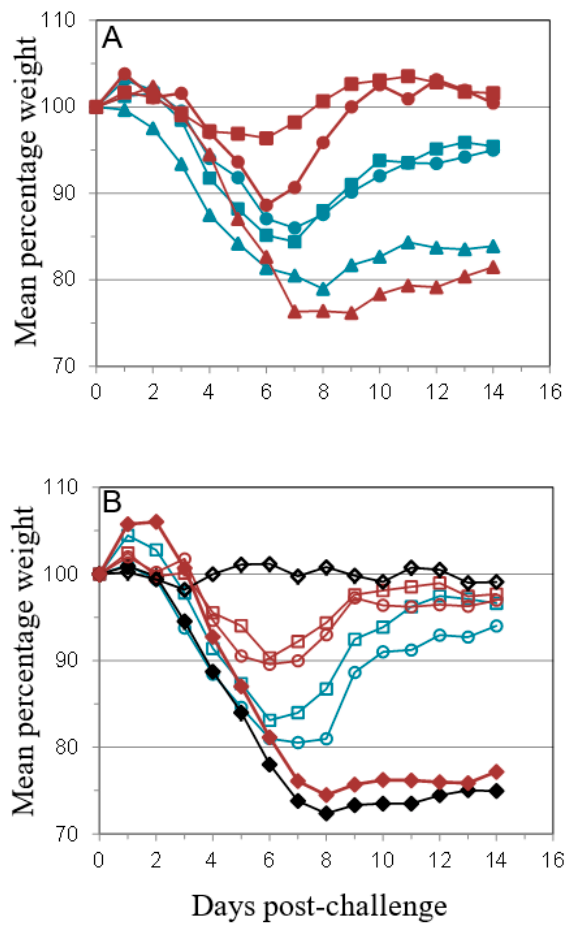
Figure 1. Vaccinia virus (VACV) Challenge of vaccinated animals. Daily post challenge weight profile for animals vaccinated with PBS ( ); PBS/CpG ( ); VACV Lister ( ); or protein subunits adjuvanted with alhydrogel or CpG; and challenged with 100 median lethal doses (MLD) of VACV IHD. Protein combinations were A27/B5/alhydrogel )A27/B5/Cp ); A33/B5/alhydrogel ( );A33/B5/Cp ); A27/A33/alhydrogel ); ); or A27/A33/B5/L1/CpG ( animal received 10 µg (divalent, A ), 6.7 µg (trivalent, B ) or 5 µg (quadrivalent, B ) of each protein for each immunization. A total of three immunizations were given at 21-day intervals, with challenge at 21 days after the 3rd immunization. PBS/CpG was administered on the same schedule as protein immunizations. Lister vaccination was given only once, with a dose of 1 × 10 6 pfu on a shaved flank, as previously described [38]. Lister vaccinated animals were bled once 21 days post vaccination and challenged at 28 days post vaccination, with the other groups. PBS controls were on the same schedule as Lister vaccination. Data is presented as daily means of the weight of each surviving animal as a percentage of its initial weight. Statistical analysis was by Analysis of Variance (ANOVA) and 2-way ANOVA.